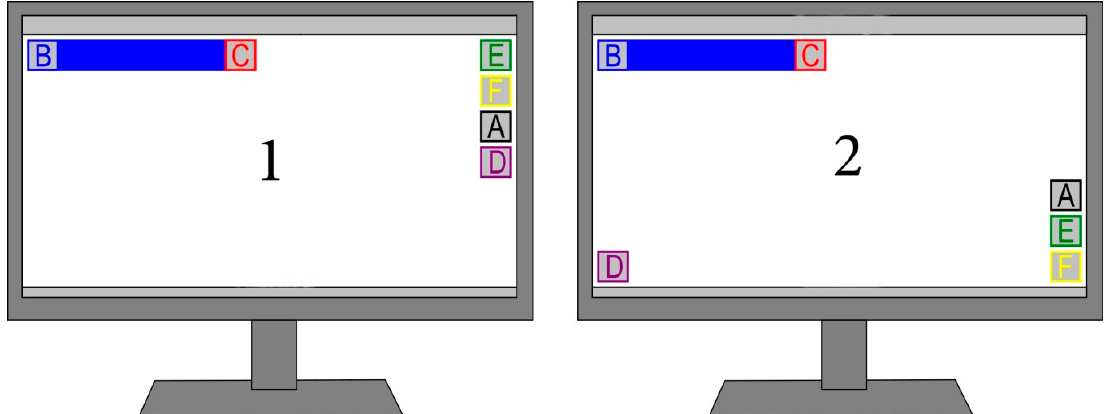
Figure 2. Buttons placement on the computer monitor according to ( 1 ) OpenStreetMap and ( 2 ) Google Maps. Letters indicate buttons: (A) geolocation, (B) search, (C) route, (D) change layers, (E) zoom in, and (F) zoom out.